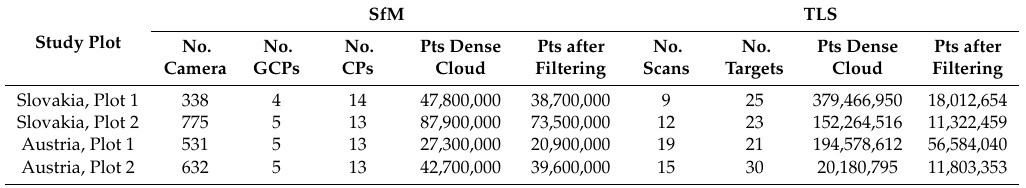
Table 2. Overview of the conducted photogrammetric and TLS surveys, and the resulting point clouds. Study